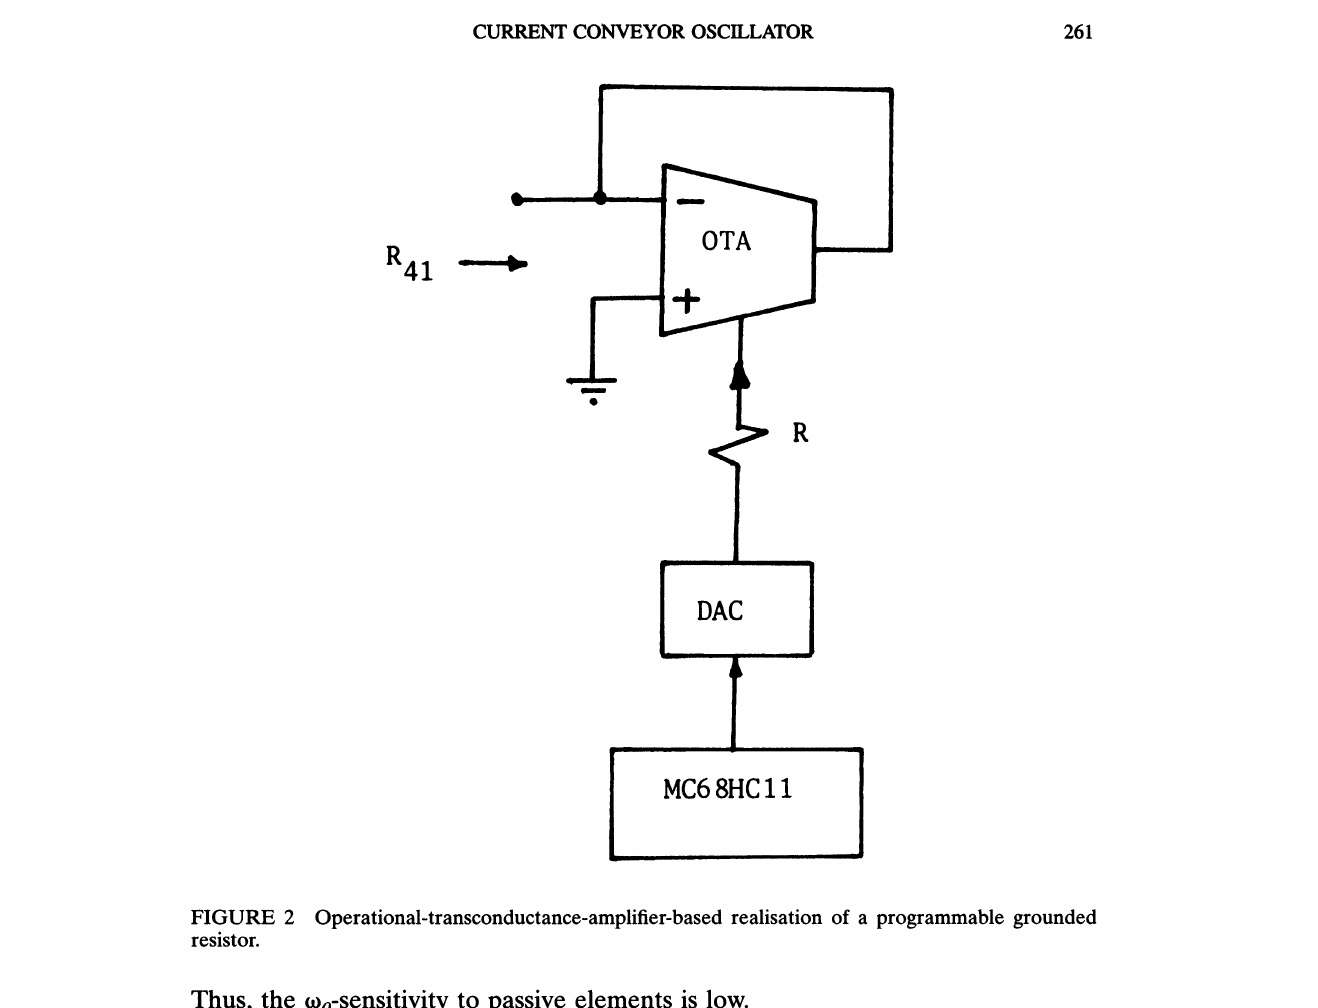
FIGURE 2 Operational-transconductance-amplifier-based realisation of a programmable grounded